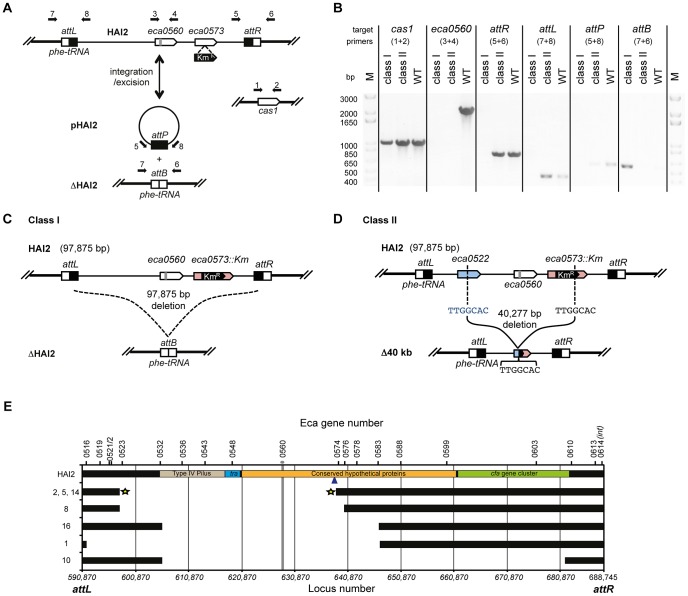
CRISPR/Cas–mediated chromosomal targeting causes rapid genome evolution.(A) Schematic of HAI2 inserted in the P. atrosepticum genome. The attL and attR sites are indicated by black and white boxes respectively, eca0560 and eca0573 are shown as white arrows and the protospacer in eca0560 is indicated in grey and the KmR marker in eca0573 is depicted in black. Excision of HAI2 results in the circularised form, pHAI2, which contains the attP site and results in the generation of the attB site located within the phe-tRNA gene in the genome. In the absence of the circularised pHAI2 form, the strain is designated ΔHAI2. Primers used for strain confirmation in (B) are shown as black arrows and the cas1 gene was used as a positive control. (B) PCR results for representative class I and class II mutants and the WT. PCR was performed for cas1, eca0560, attR, attL, attP and attB and with primers shown in part (A). Schematic representations of (C) the class I mutants (designated ΔHAI2) that have precisely lost the 97,875 bp island and (D) the class II mutants 2, 5 and 14 containing a 40,227 bp deletion between TTGGCAC sequences in both eca0522 and internal to the KmR insertion in eca0573. (E) Scale genetic map of the 7 classified HAI2 class II mutants defining the deleted regions. Black bars indicate the presence of the gene as specified. The gray vertical line represents the CRISPR-targeted eca0560 gene. The star represents three accurately sequenced junctions. The blue arrow depicts the site of Km insertion within the chromosome. Class II mutants are numbered as in Figure S4 and their PCR profiles are shown in Figure S5.